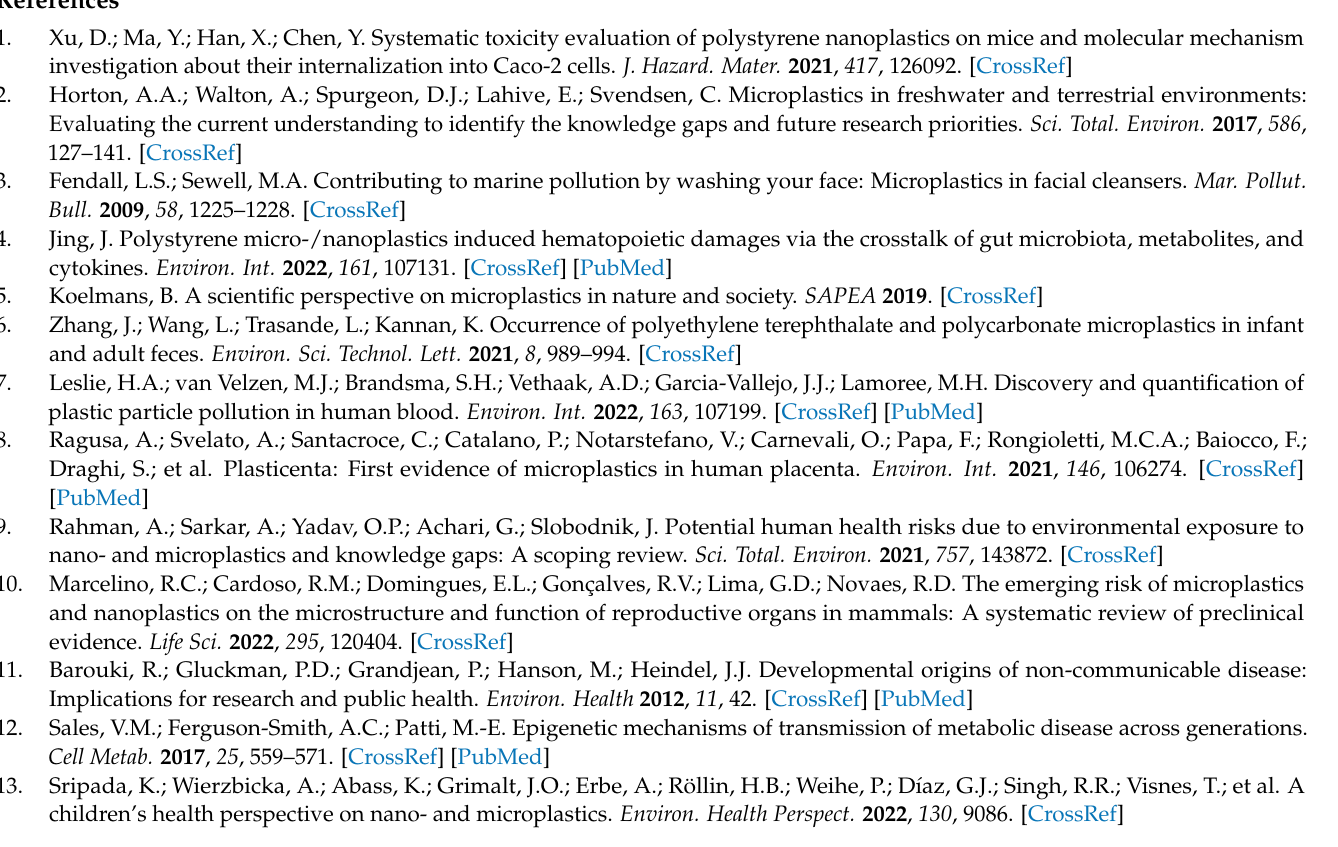
Table S1. Histomorphometric data of female rats treated with PS-MPs at a dose level of 0, 0.5, and 2.0 mg/kg per day during the juvenile period (PND 28-56). Table S2. Histomorphometric data of female rats treated with deionized water (Group C), PS-MPs (Group I), PS-MPs + NAC (Group II), and PS-MPs + Sal (Group III) during the juvenile period (PND